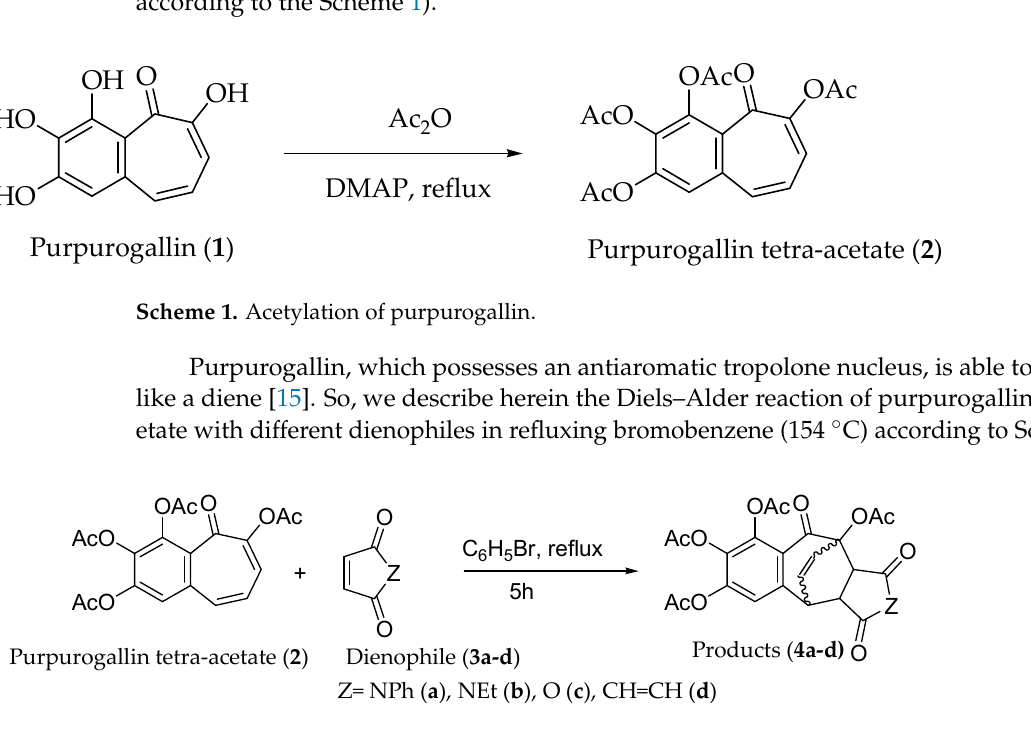
Scheme 2. Diels–Alder reactions between purpurogallin tetraacetate and various dienophiles ( 3a - d ).